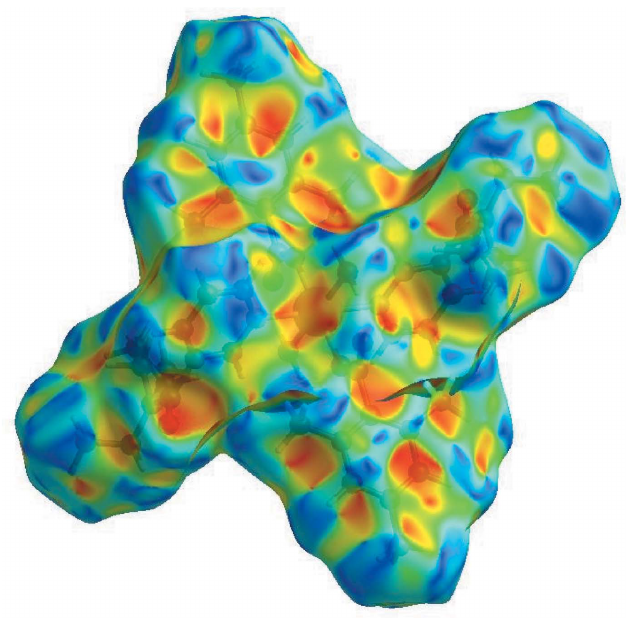
Figure 4 View of the three-dimensional Hirshfeld surface of the title complex plotted over electrostatic potential energy in the range (cid:4) 0.1032 to 0.1415 a.u. using the STO-3G basis set at the Hartree–Fock level of theory. The O—H (cid:3)(cid:3)(cid:3) O and C—H (cid:3)(cid:3)(cid:3) O hydrogen-bond donors and acceptors are viewed as blue and red regions around the atoms corresponding to positive and negative potentials, respectively.